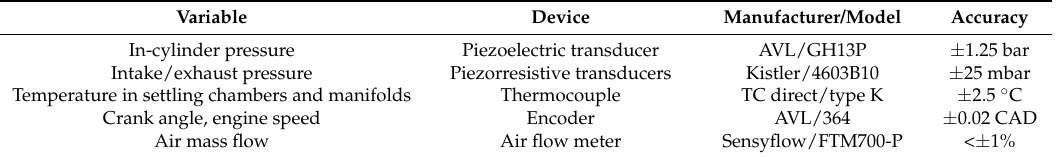
Table 1. Test cell instrumentation.